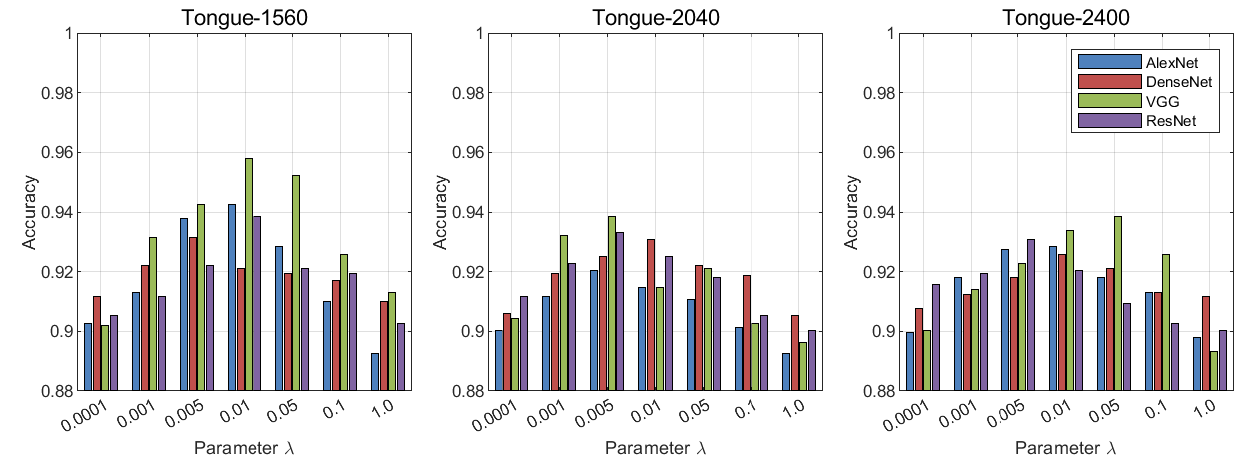
Figure 9. Comparison of mean overall accuracy under different values (Softmax classifier).